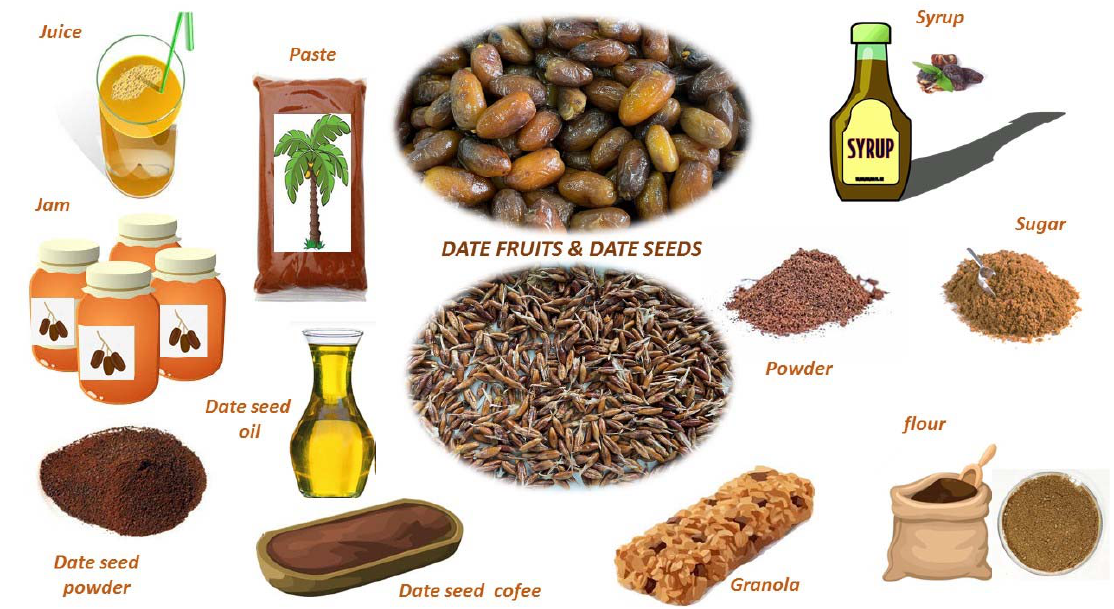
Figure 1. Variety of food products based on date fruit and